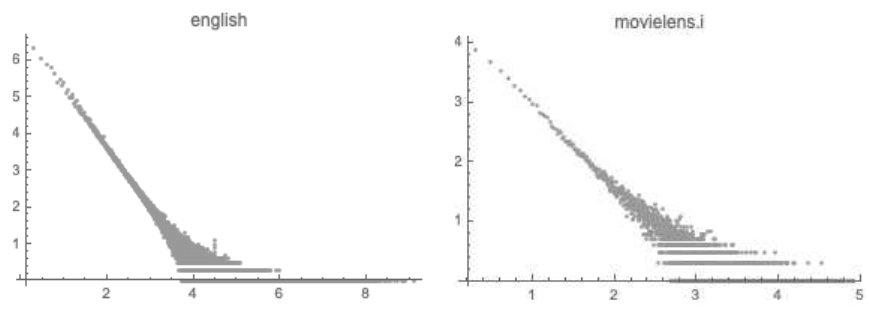
Figure 3. Frequencies of English words ( on the left ) and of MovieLens ratings ( on the right ).